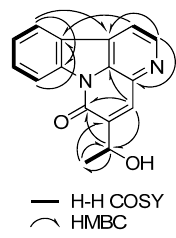
Figure 2. 1 H- 1 H COSY and HMBC correlations of 1 .